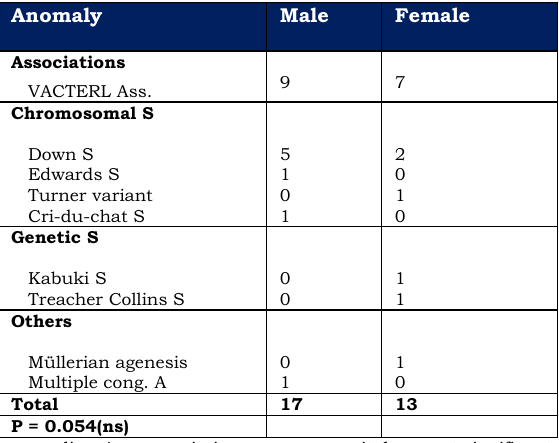
Table 2: Associations, chromosomal and genetic anomalies (30/28.6